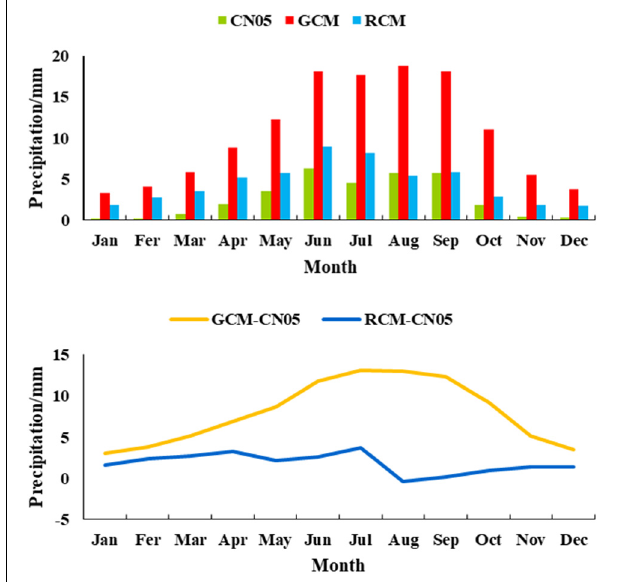
FIGURE 7 | Monthly mean precipitation and deviation of different scale models and observation data.